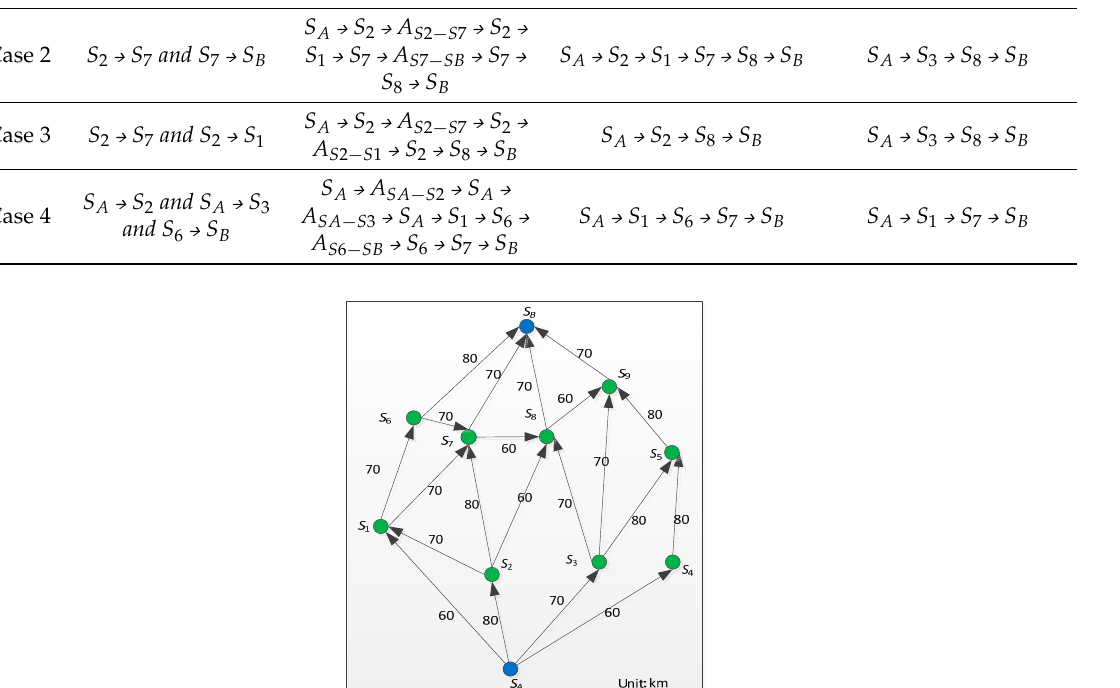
Figure 5. The average speed and direction of road segments from A to B .